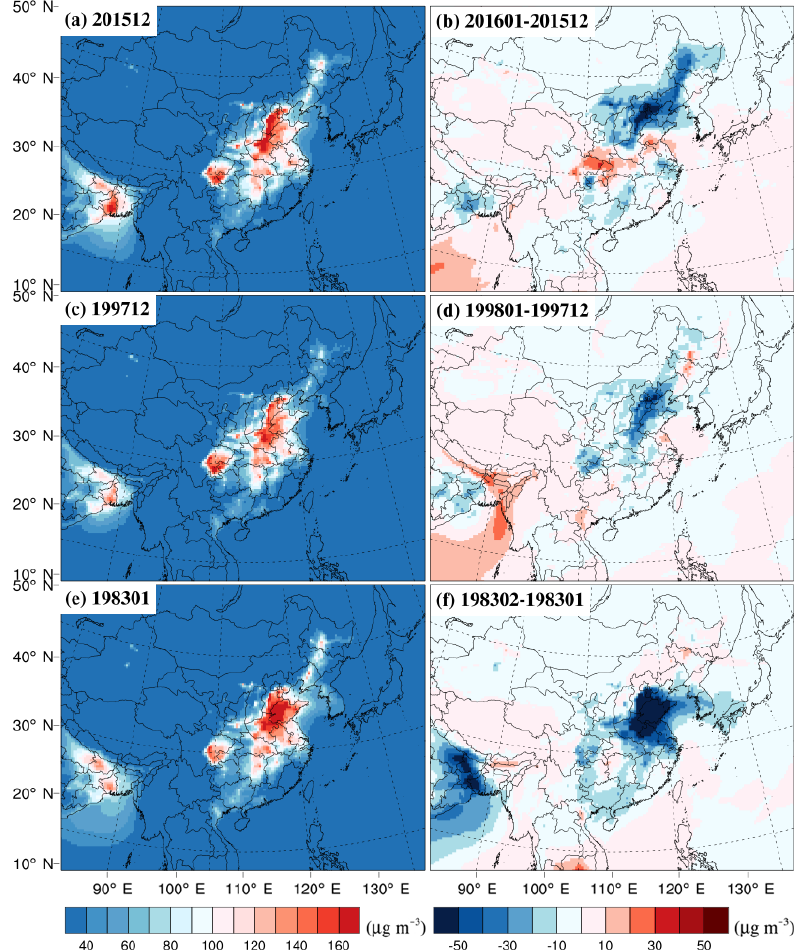
Figure 6. Monthly mean PM 2 . 5 during the three super El Niño events, i.e., December 2015 (a) , December 1997 (c) and January 1983 (e) and the differences of PM 2 . 5 compared to the following month (b, d, f)